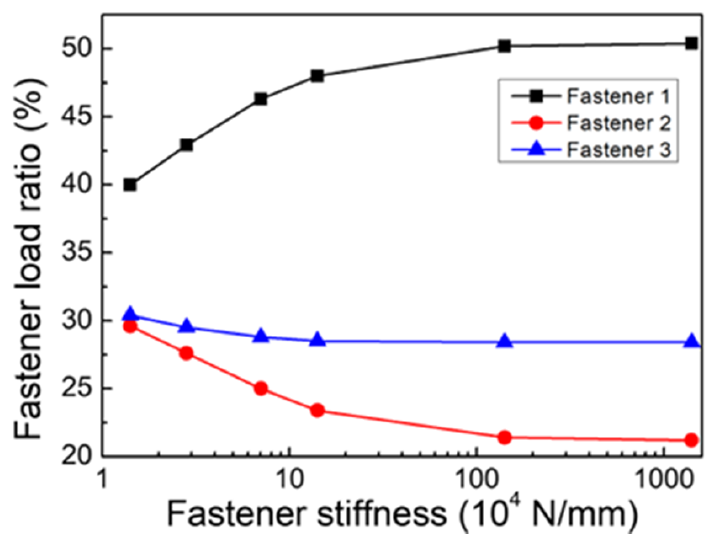
Figure 8. Variation of the pin-load distribution ratio of fasteners with the applied load in the three-bolt joint.